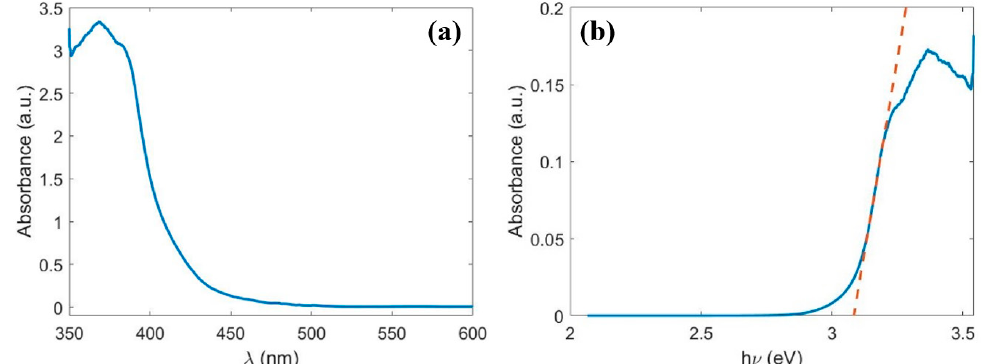
Figure 5. ( a ) UV–visible absorbance of F,O,S-codoped g-C 3 N 4 in terms of Kubelka–Munk absorbance units, and ( b ) Tauc plot.